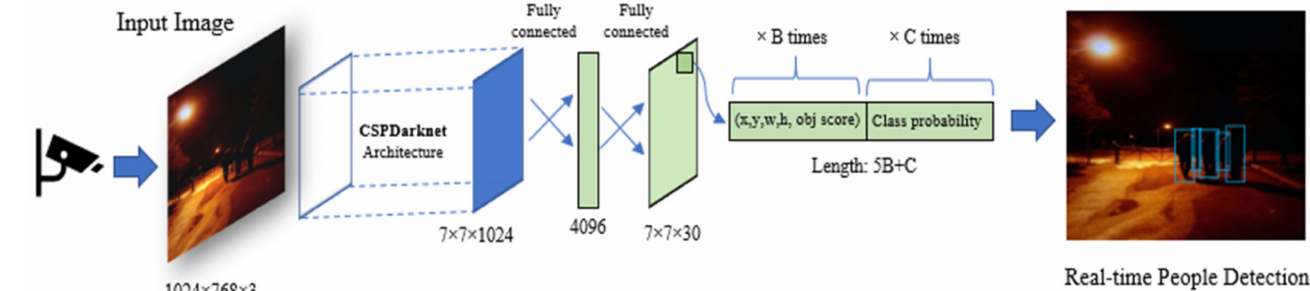
Figure 3. YOLO-based real-time people